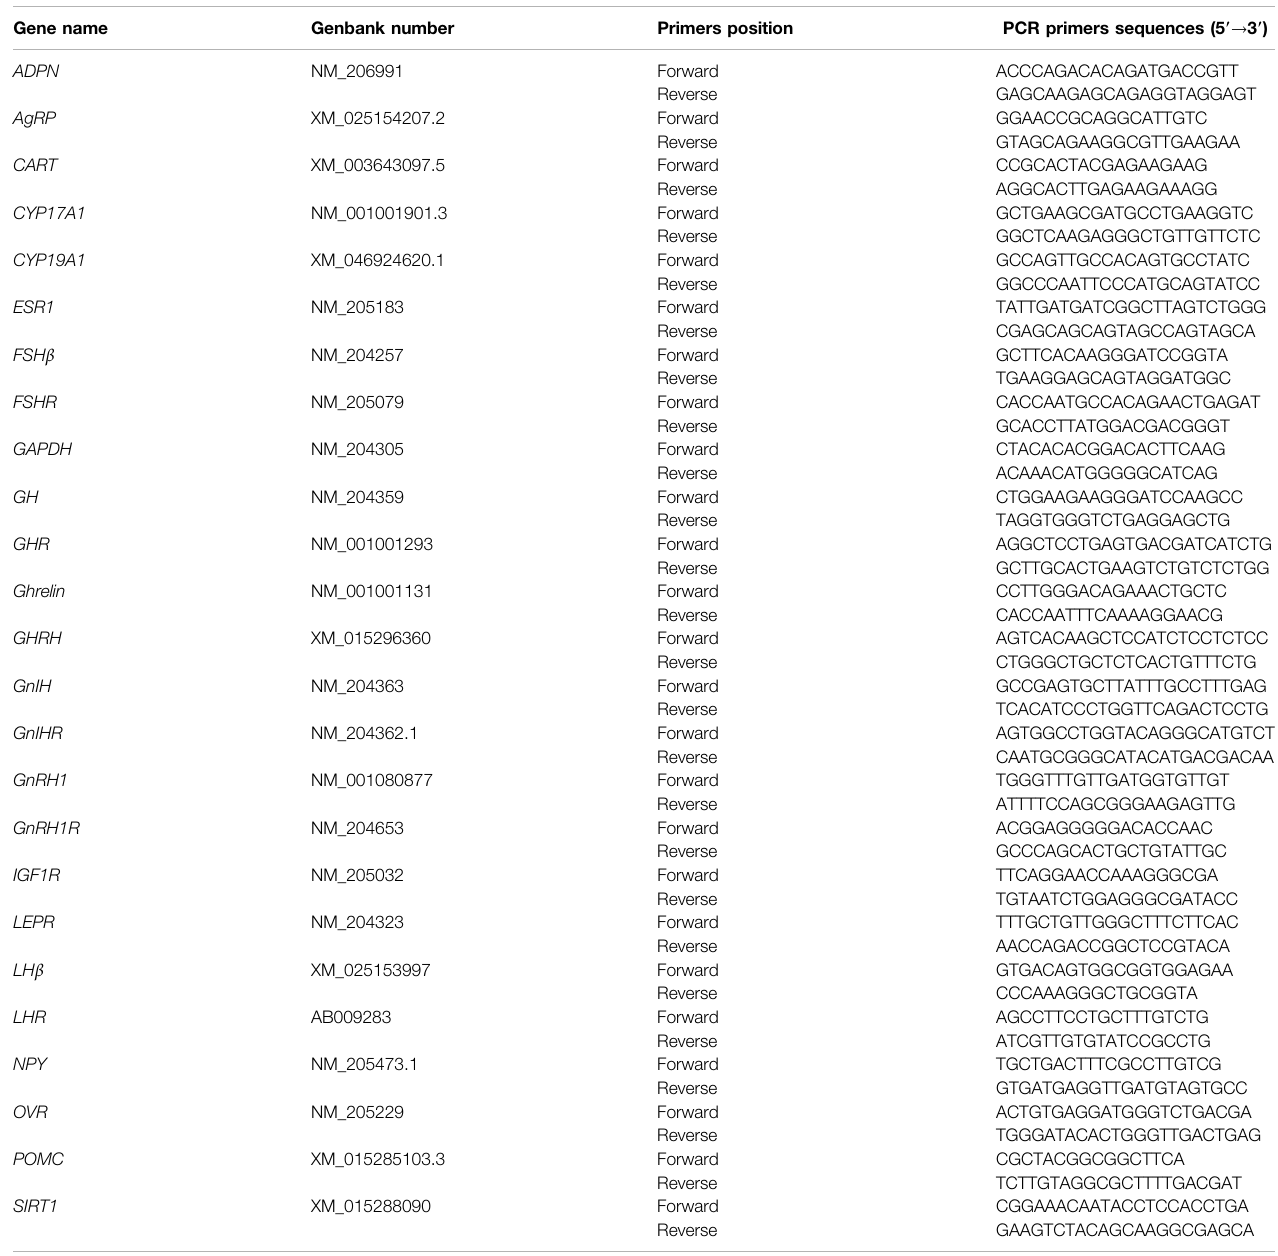
TABLE 2 | Primers used for real-time quantitative